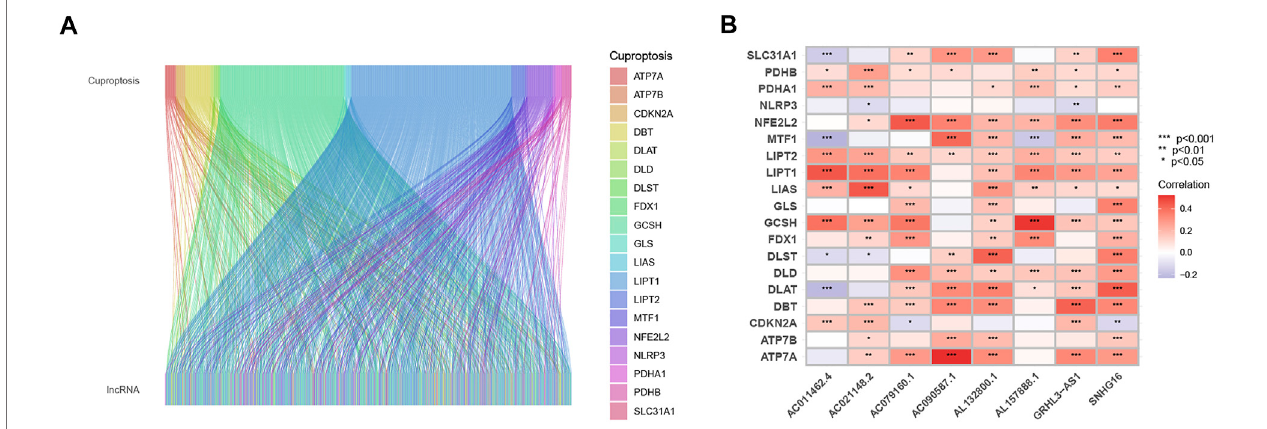
FIGURE 1 | Sankey diagram and heat map. (A) Sankey diagram of coexpression between 19 cuproptosis-related genes and 783 cuproptosis-related long noncoding RNA (lncRNAs). (B) correlation 19 cuproptosis-related genes and 8 prognostic cuproptosis-related lncRNAs. * p < 0.05, ** p < 0.01, and *** p < 0.001.